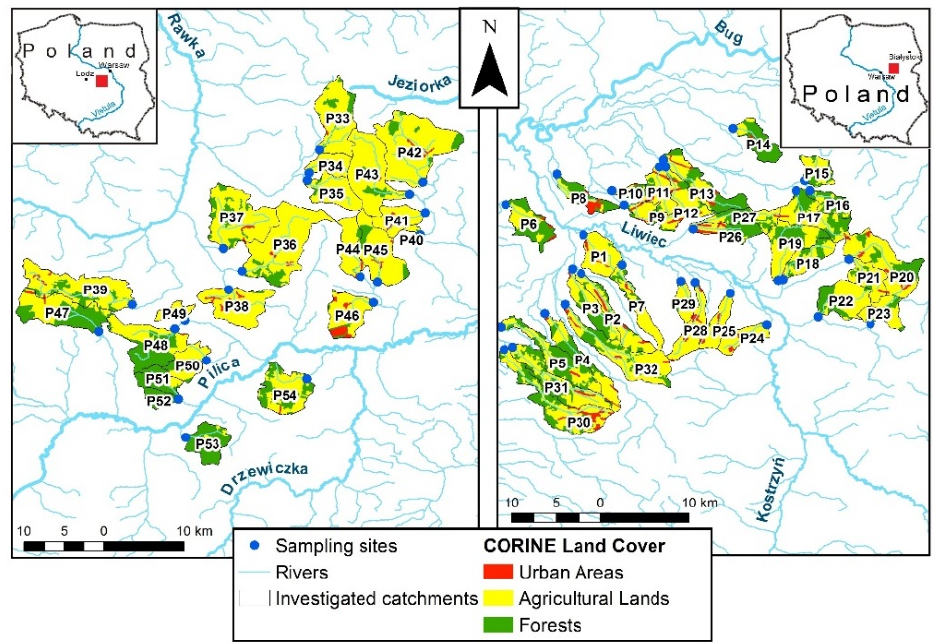
Figure 1. The localization of investigated catchments on the background of the Corine Land Cover data and drainage system based on a digital hydrographic map of Poland